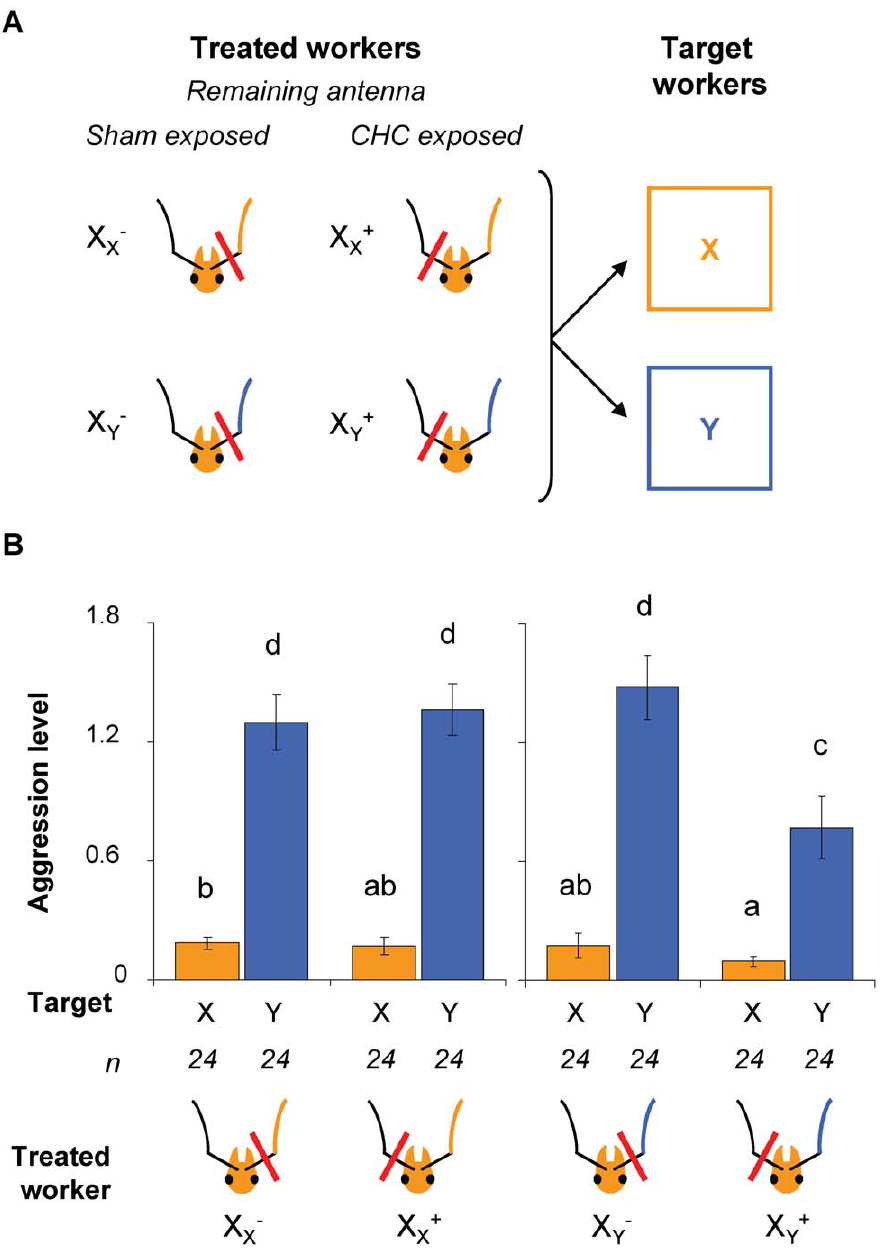
Figure 2. Effect of unilateral antennal exposure to alien colony odor. ( A ) Experimental design. Antennae of workers from colony X were inserted into two capillaries (see also Figure 1B), one of which was treated with solvent (sham exposed, 2 ) while the other was coated with CHCs (CHC-exposed, + ) from either nestmate workers (control X X ) or non-nestmates from colony Y (test X Y ). After 18-hour exposure, one antenna was selectively excised. Aggression tests between treated workers and anaesthetized target workers from colonies X or Y were performed immediately after excision as indicated by the arrows. ( B ) Aggression level of treated workers towards targets from colonies X (yellow bars) and Y (blue bars). Columns and error bars indicate mean and standard error of aggression indices respectively. Different letters indicate significant differences between categories (mixed-effects model with least square means post-hoc comparisons, P , 0.05). When their remaining antenna had been exposed to non- nestmate CHCs (X Y + ), workers were significantly less aggressive towards non-nestmates from colony Y than when their remaining antenna had been sham exposed (X Y + –Y vs. X Y 2 –Y, P , 0.0001). X Y + workers were also less aggressive towards Y-individuals than control workers, which had been exposed to nestmate odor (X Y + –Y vs. X X + –Y, P , 0.0001; X Y + –Y vs. X X 2 –Y, P , 0.0001). The aggressiveness of control workers (X X ) towards Y-individuals was always high and did not depend on which antenna was excised (X X + –Y vs. X X 2 –Y, P =0.821).